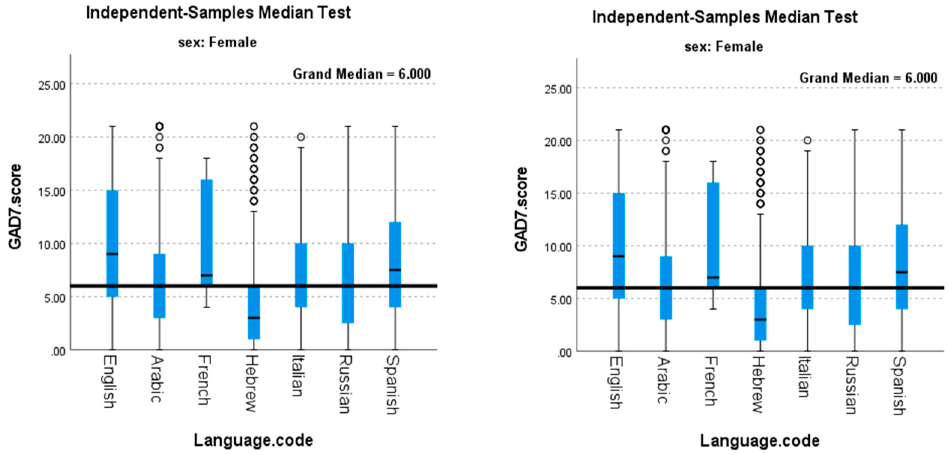
Figure 2. GAD-7 Scores by Sex and Language in which Survey was Completed. Table 5. Multivariable Logistic Regression Model of Moderate Anxiety or Greater (GAD-7 score ≥ 10).